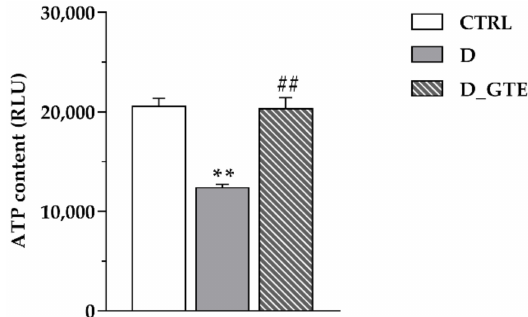
Figure 2. Mean values ± SEM of ATP content measured in CTRL, D and D_GTE cardiomyocytes. Val- ues are expressed as relative light units (RLUs), normalized to the protein content. ** p < 0.01 significant differences vs. CTRL; ## p < 0.01 significant differences vs. D (GLM ANOVA for repeated measurements).